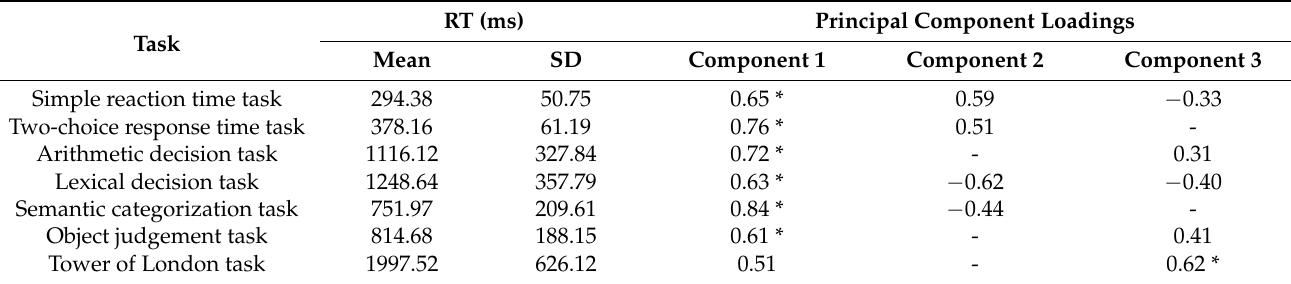
Table 1. Means, standard deviations and loadings of each task RT on all three components. RT Task